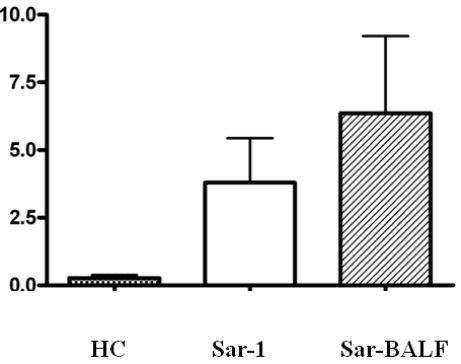
Figure 4. The ratio of Th17/Treg cells in healthy controls (HC) and sarcoidosis patients (Sar-1), and in the BALF of sarcoidosis patients